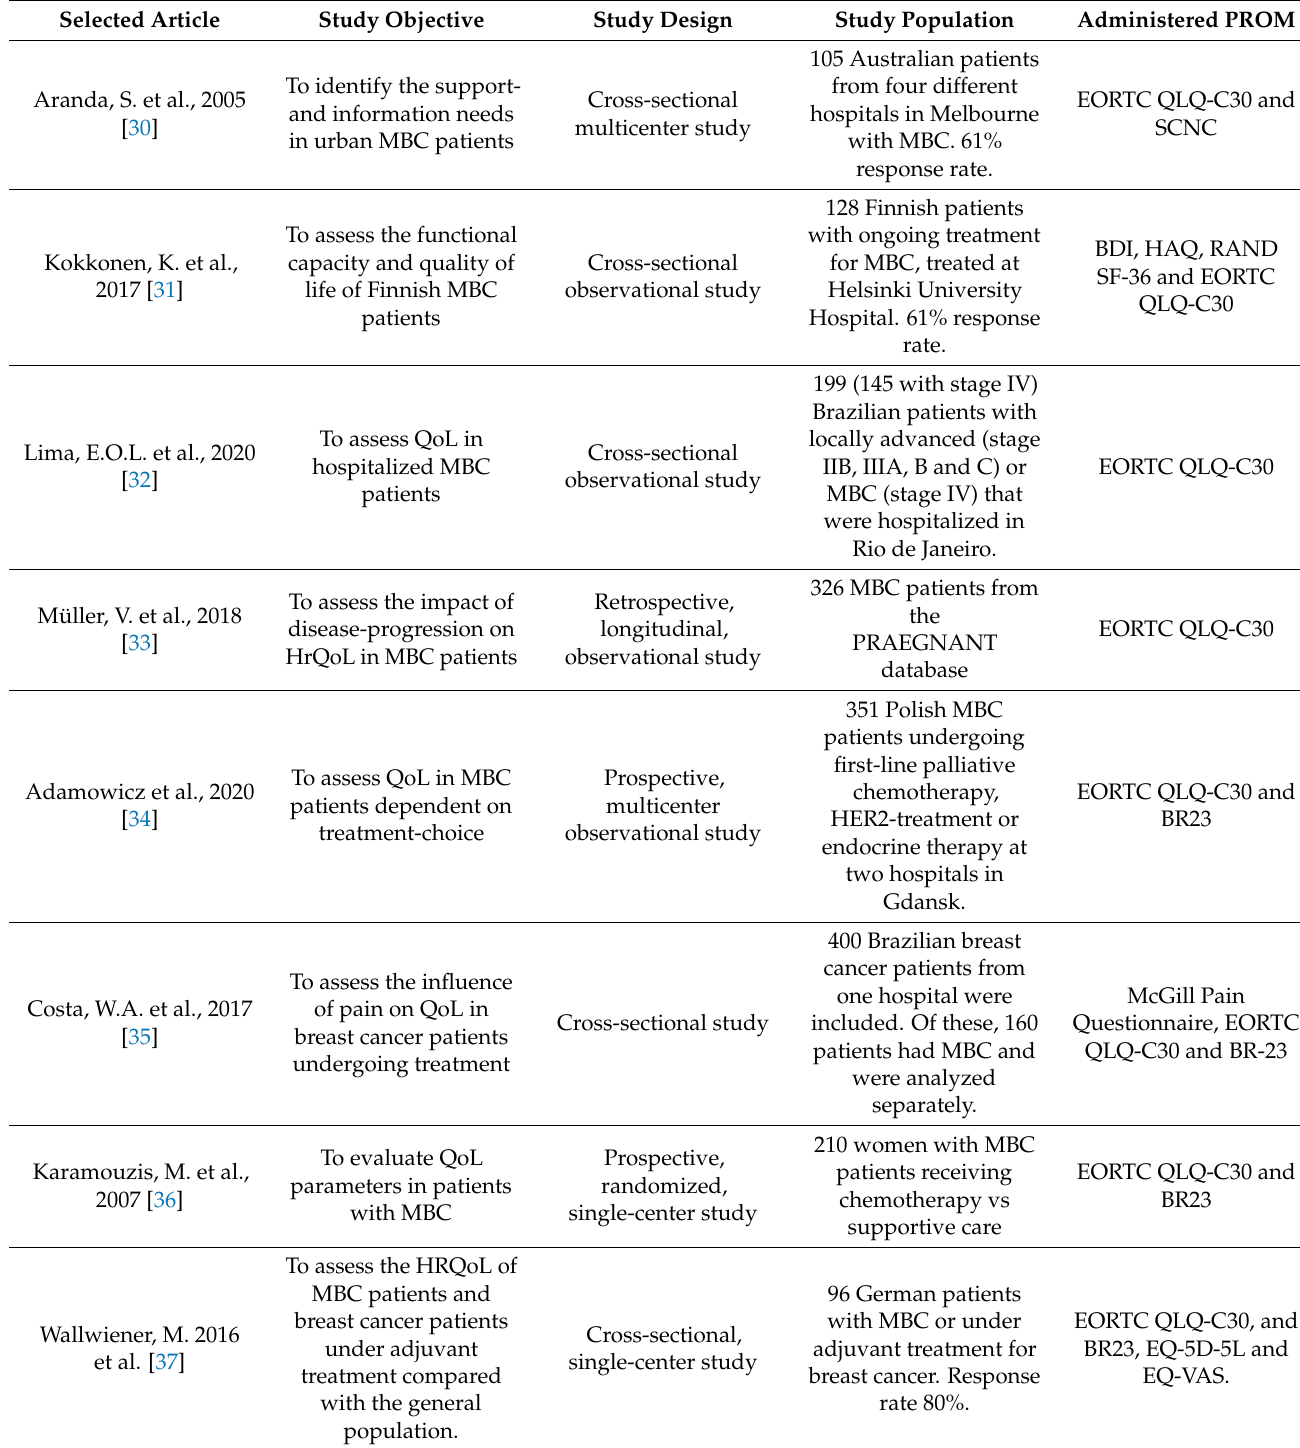
Table 2. Instruments used for health-related quality of life (HRQoL) measurements in metastatic breast cancer (MBC)